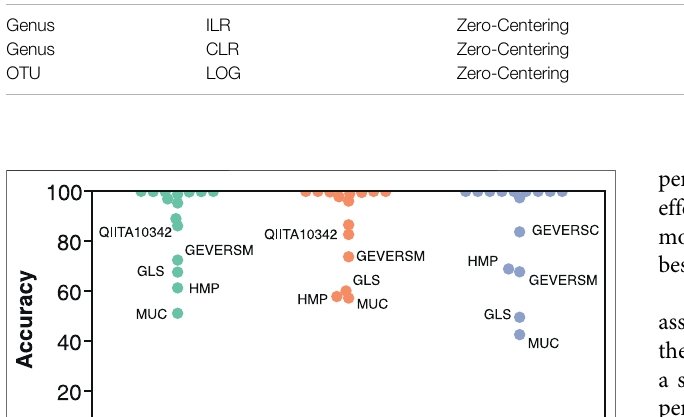
TABLE 4 | Top three data processing and model pipelines for classifying IBD samples. Three combinations which appeared when all pipelines were sorted by F1 score or MCC. Features